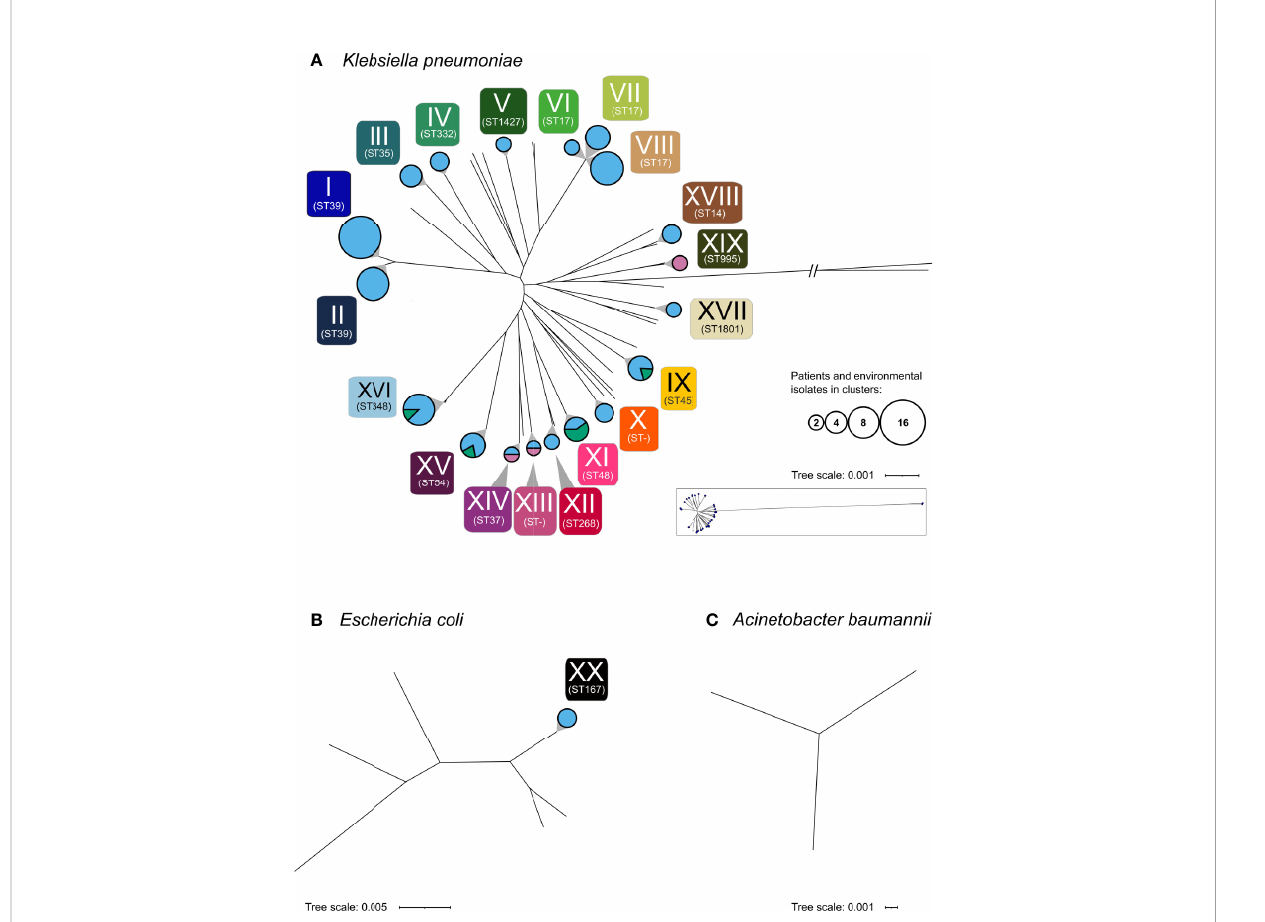
FIGURE 2 Phylogenetic analysis of the 160 sequenced isolates. Phylogenetic analysis revealed 20 clusters (I-XX) depicted as circles. (A) K. pneumoniae , (B) E. coli , (C) A. baumannii. Circle areas represent the number of patients and environmental samples forming the cluster, while the circle color indicates the respective sample types (rose, maternal; light blue, neonatal; green, environmental). Multilocus sequence types (ST) of clusters are shown below each cluster. Non-typable sequence types are designated as “ ST- ” . Sequence types of all particular isolates are given in Supplementary Table